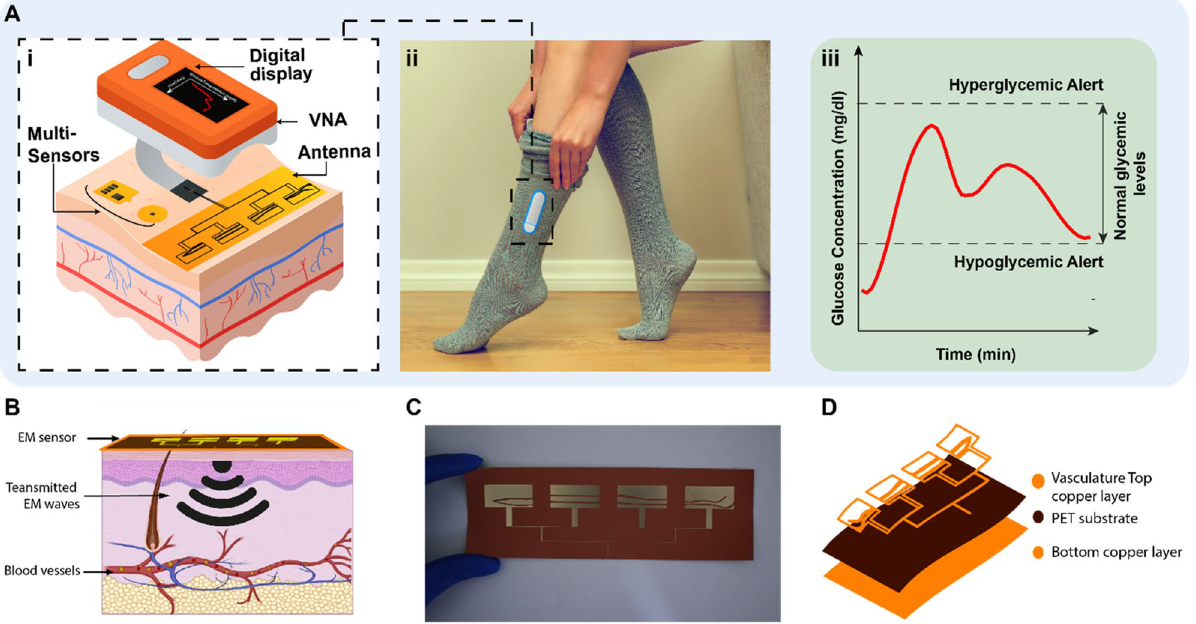
Figure 1. Principle of a multi-sensing, multi-location approach. ( A ), i, the system is composed of two sensors targeting two on-body locations. Additional environmental and physiological sensors are added to the system to calibrate the temperature, humidity, sweat, and motion effects. ii, all these sensors are worn within the sock apparatus. iii , the system provides the glucose levels in mg/dl using a machine learning algorithm. ( B ) Targeted blood vessels to provide information about the blood dielectric properties. The reflected EM waves are monitored and correlated to the blood glucose variation. ( C ) Top sensing layer of the flexible leg sensor prototype. ( D ) The layer-by-layer layout of the integrated leg sensors where the bottom layer is composed of copper, the middle layer is a PET substrate and the top layer is a copper